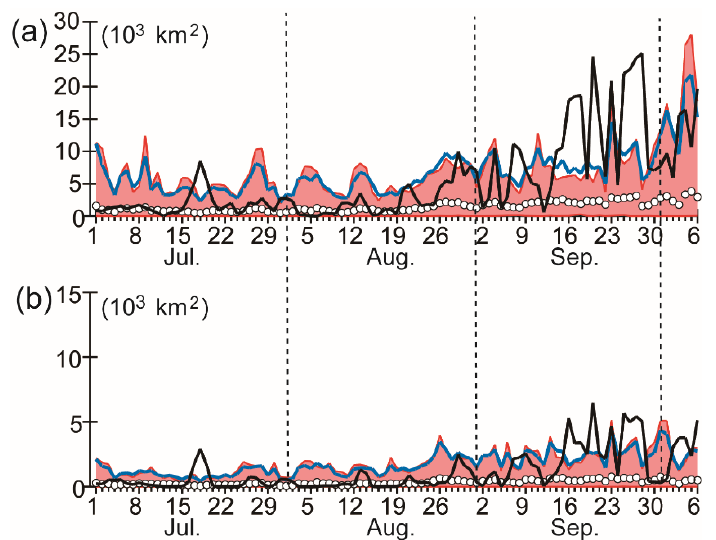
Figure 4. Daily areal extent of high SCCs exceeding ( a ) 5 and ( b ) 10 mg m − 3 within the focal region in Figure 3. White circles denote climatological daily means over the 23 years (1998–2020), and the blue line indicates the climatological daily mean plus 3 standard deviations. Red shading shows the range between the daily minimum and maximum over the 23 years. SCCs were calculated from near-real-time and reprocessed L4 products.